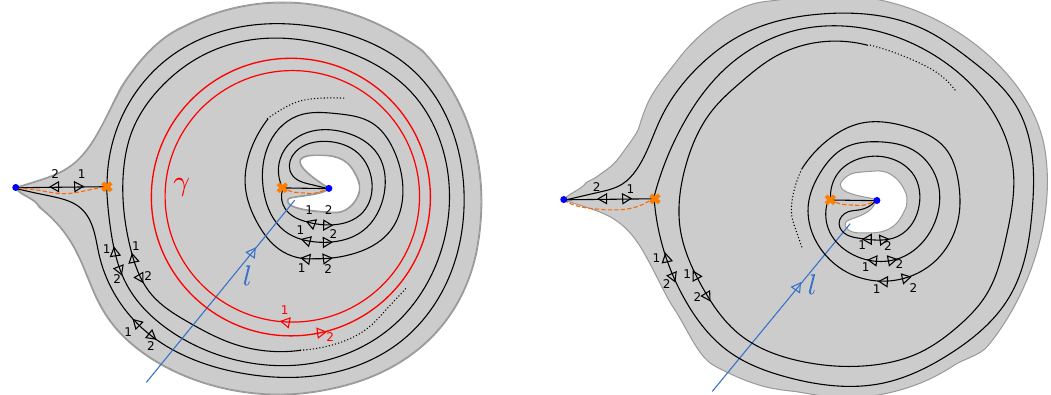
Figure 74 . A region C (cid:14) of C bounded by generic leaves of the WKB foliation, and degenerated versions of the WKB foliation contained therein, immediately before (left) and after (right) crossing a vector multiplet K -wall. The picture is a bit schematic; the leaves which end in dotted lines should be understood as winding in(cid:12)nitely many times around the annulus, and l crosses each of these leaves in(cid:12)nitely many times. The charge (cid:13) of the vector multiplet is also shown on the